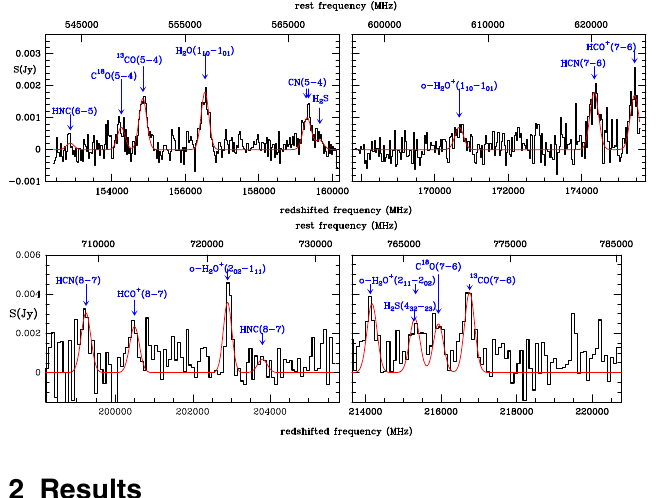
Figure 3. NOEMA 2-mm and 1-mm spectra of the Cloverleaf Quasar. As in Fig. 2, the red curves show Gaussian fits to the detected lines, the Gaussian FWHM of the weakest lines being set equal to that of the strongest nearby lines. Note the detections of H 2 O, H 2 O + , H 2 S and of the rare isotopologues C 18 O and 13 CO.